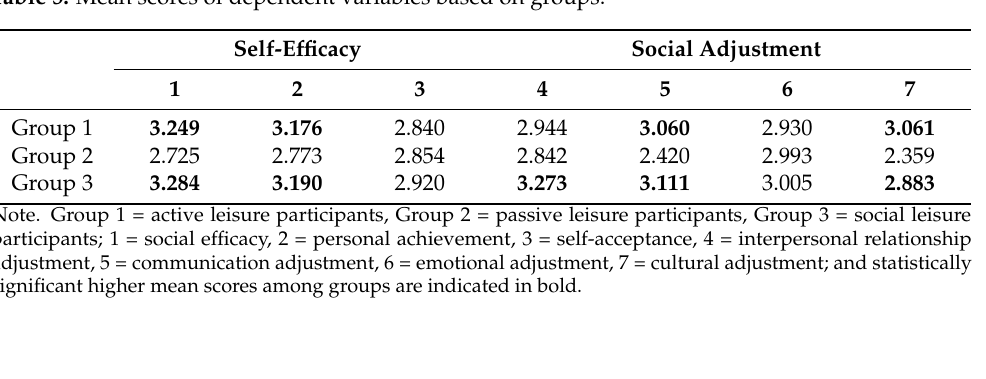
Table 5. Mean scores of dependent variables based on